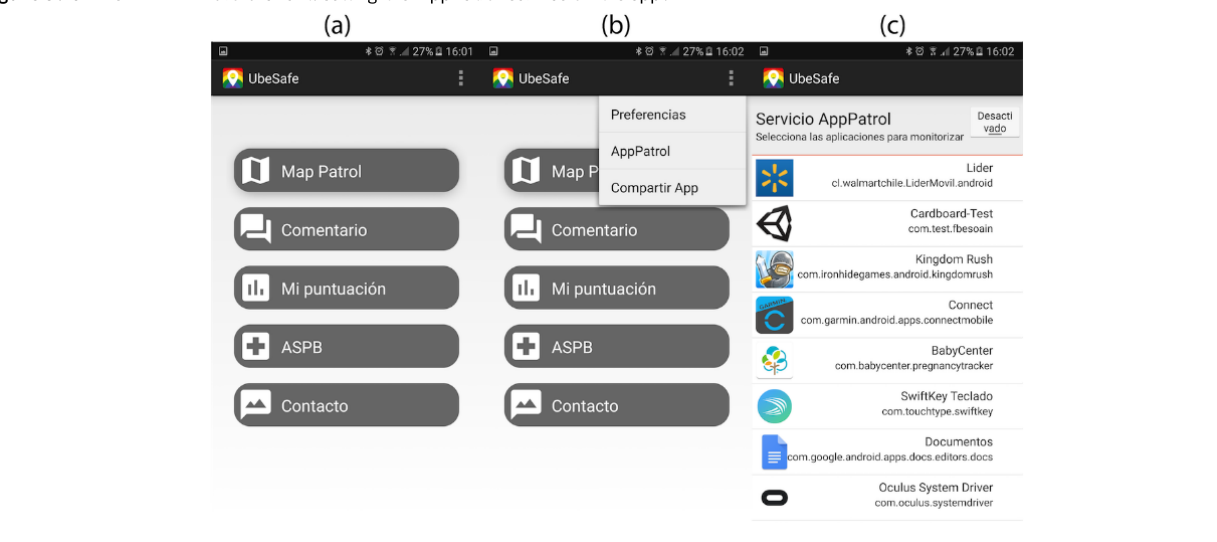
Figure 3. UBESAFE—Android client: setting the AppPatrol service on the app.